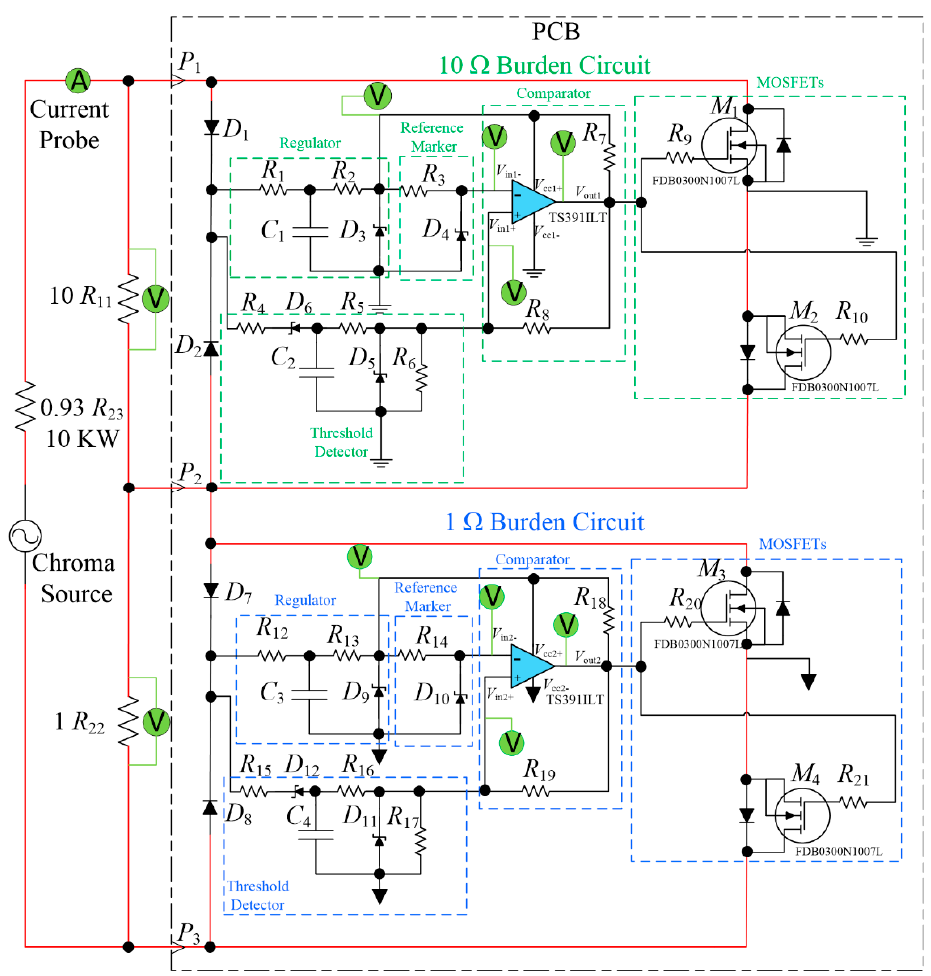
Figure 14. Component ‐ level circuit diagram of the secondary current injection test set ‐ up for the autoranging circuit.